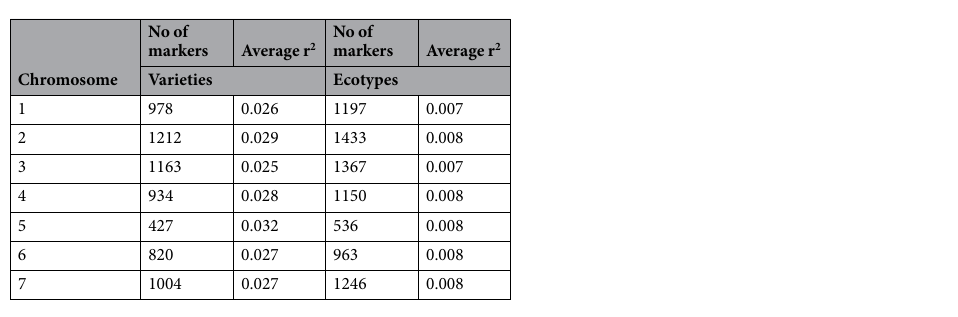
Table 3. Summary of LD decay in the varieties and ecotypes. Data collected from LDMap data and Synbreed was used to obtain the average r 2